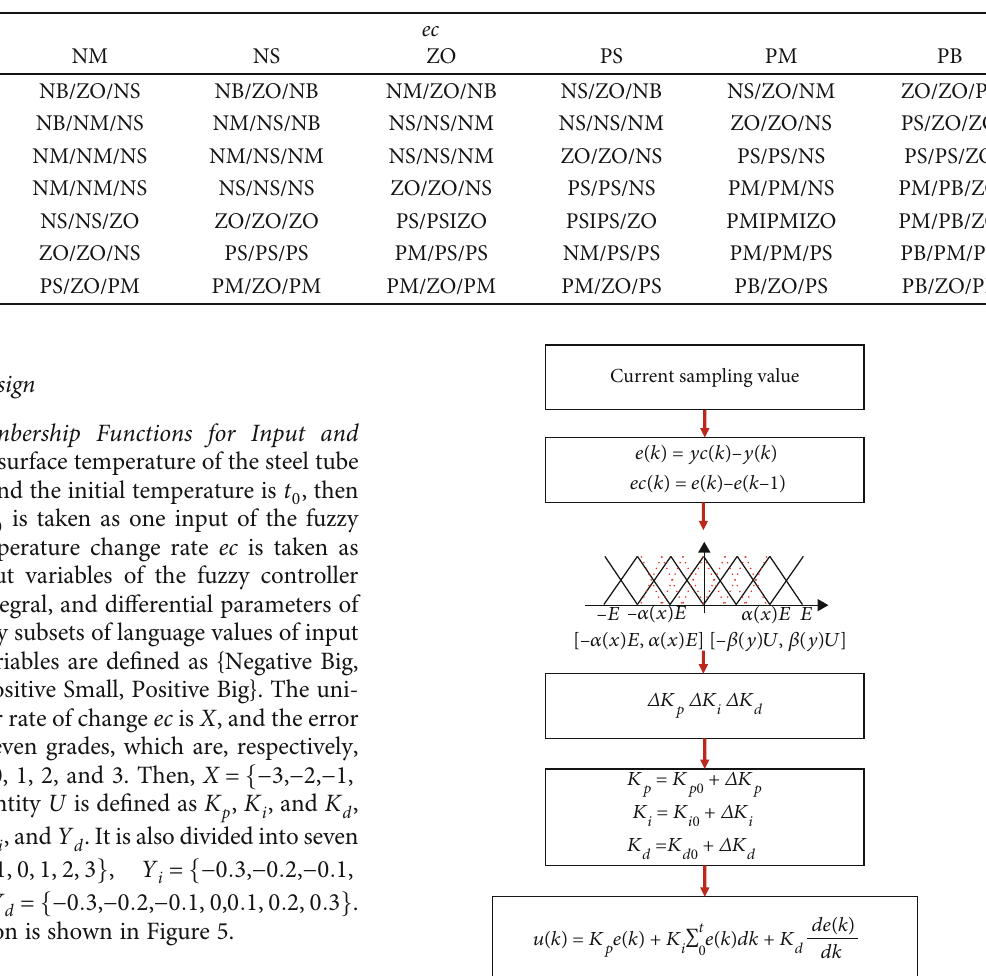
Δ K i , d . (b) The membership of Table 1: Fuzzy rule table.